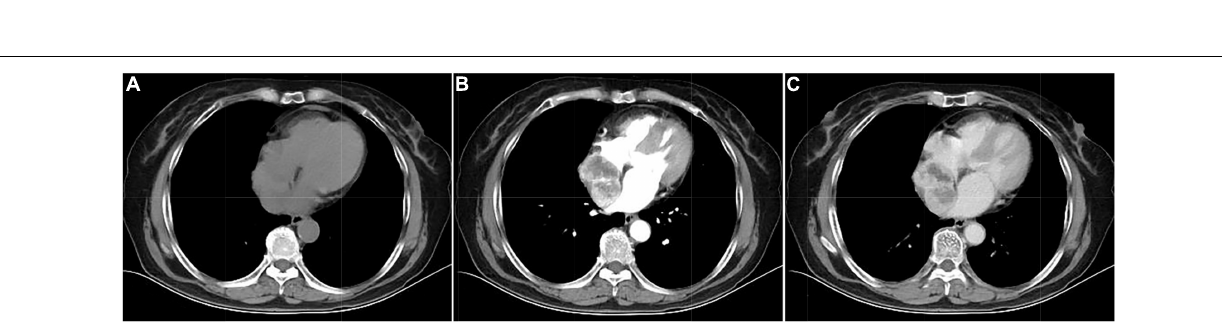
FIGURE 2 | Computed tomography images of cardiac paraganglioma. (A) Plain image; (B) arterial phase image; (C) venous phase image.